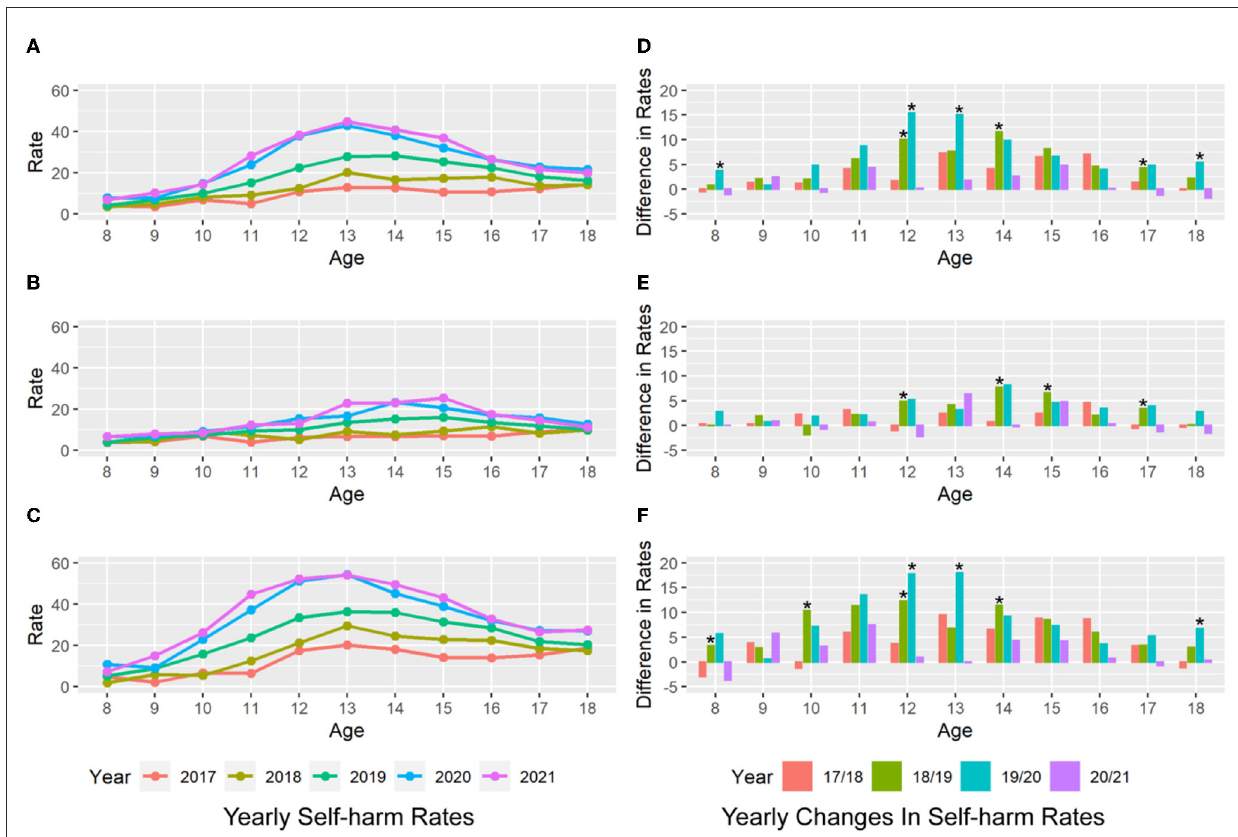
FIGURE1 Self-harm rates at different ages. The left panel shows the annual self-harm rates for the entire sample (A) of male (B) and female patients (C) at different ages. The colors indicate the different years of data. Females show an increasing trend in self-harm rates starting at age 10. The right panels show the annual change in self-harm rates for the full sample (D) , male (E) , and female patients (F) at different ages. Females aged 12–13 years show a significantly greater change in self-harm rates between 2019 and 2020 than in previous years (“ * ” represents significance in bootstrapping).